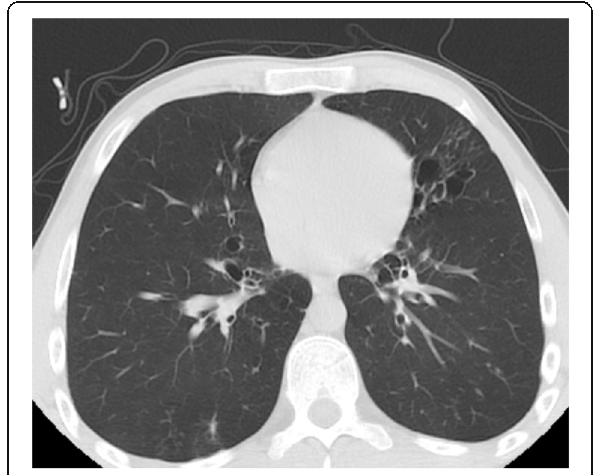
Fig. 4 No typical signs of COVID-19The CT-image shows bronchiectasis, bronchial wall thickening — CO-RADS 2. There are no ground glass